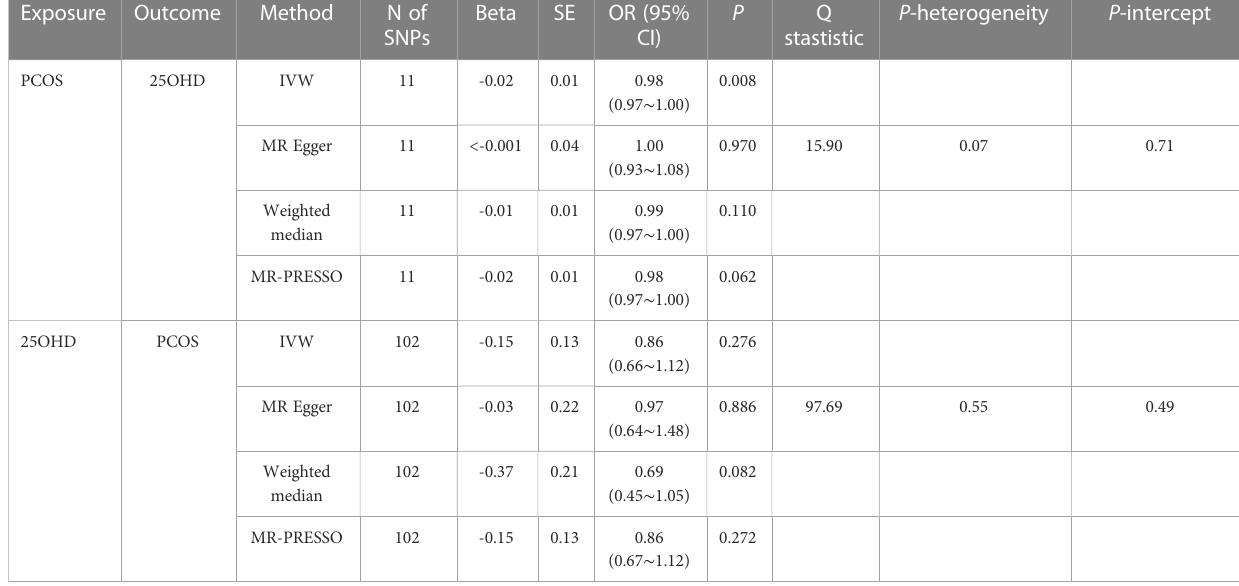
TABLE 1 Results of causal associations between PCOS and 25OHD. Exposure